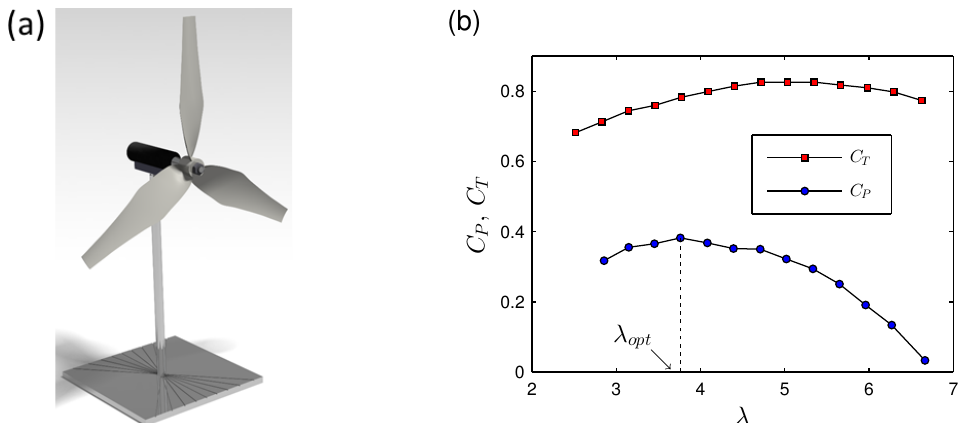
Figure 1. ( a ) Schematic figure of the miniature wind turbine placed in the turbulent boundary layer. ( b ) Variation of C T and C P with the tip-speed ratio λ for the miniature turbine placed in the boundary layer with ¯ u h = 5 ms − 1